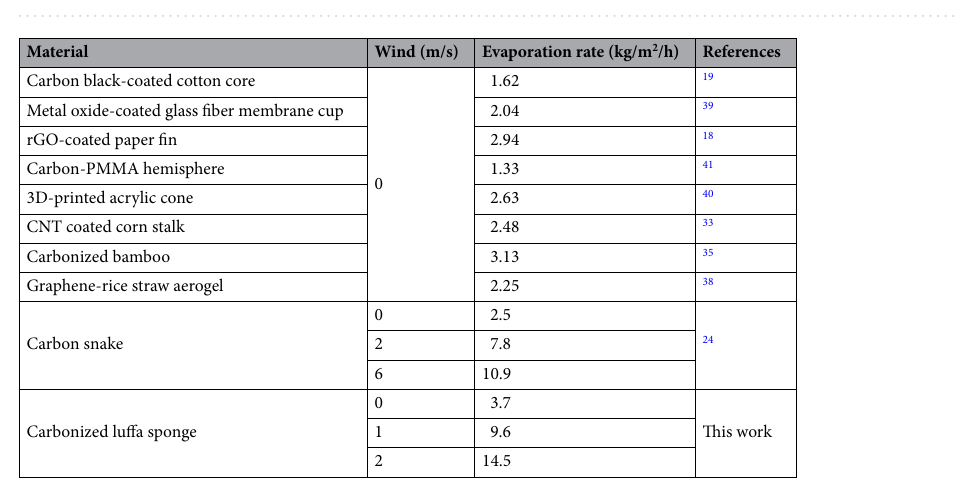
Figure 4. Photograph of ( a ) CLS, ( b ) CMF, and ( c ) PUF. The height of each sample above the water surface is 60 mm. ( d ) Dry masses (dark yellow) and wet masses (dark blue) of the CLS, CMF, and PUF. ( e ) Evaporation- induced mass change of water with each sample under 1-sun illumination. ( f ) Variation in the evaporation rate of water with CLS under 1-sun illumination over 5 days.